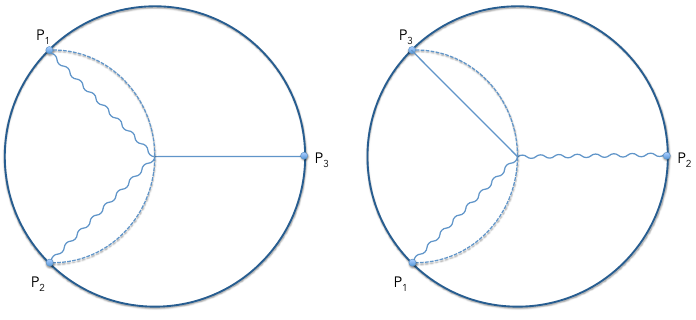
Figure 4 . The diagrams here di(cid:11)er by the choice of geodesic. Depending on this choice, a given interaction will give rise to a di(cid:11)erent tensor